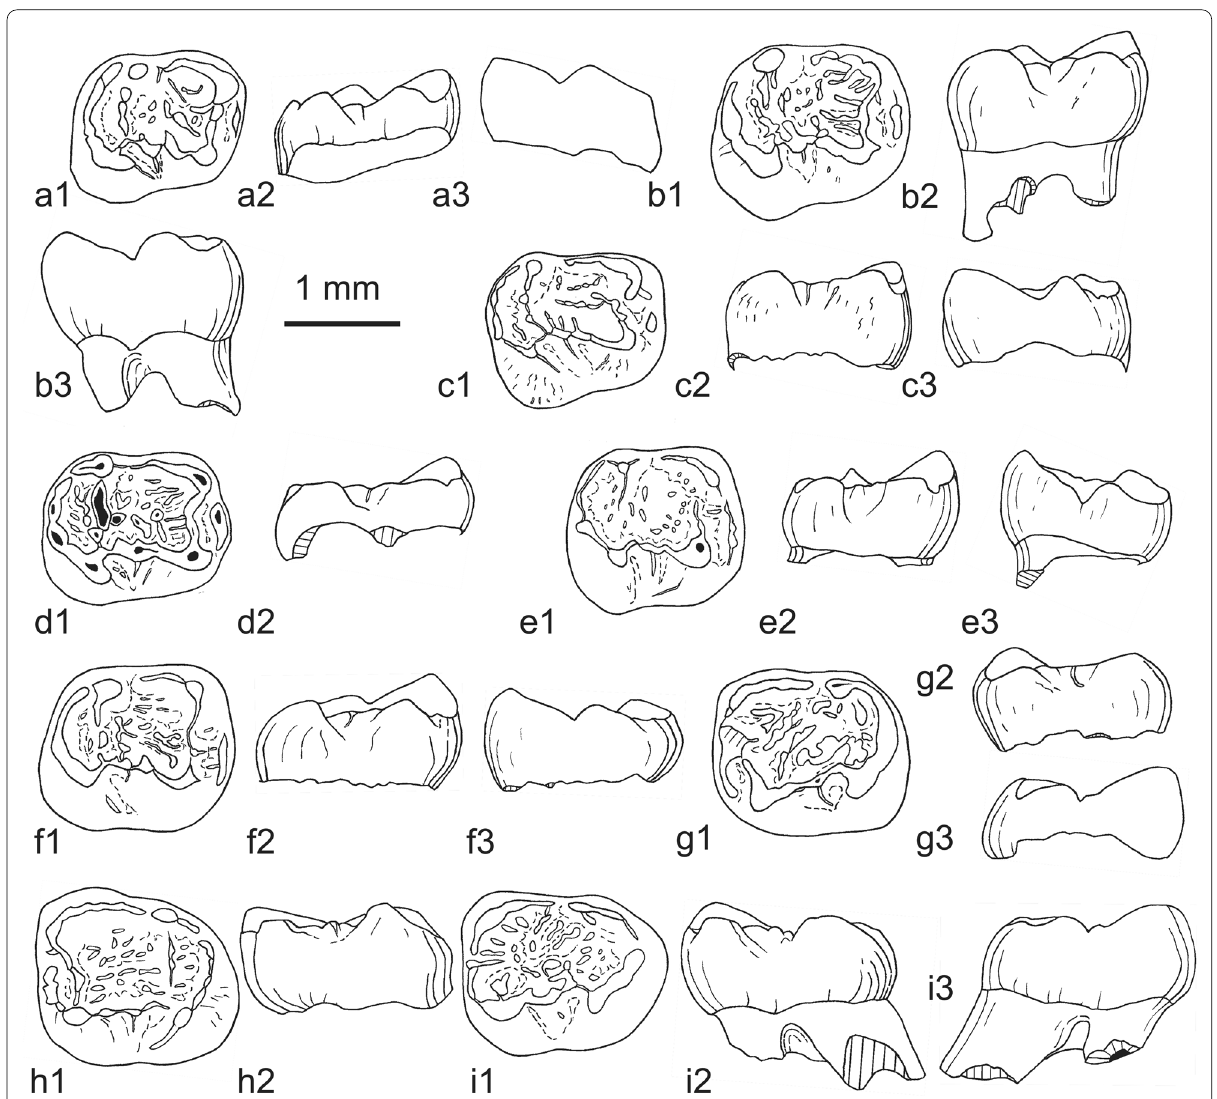
Fig. 48 Lower molars of ? Protadelomys maximini Escarguel, 1998 from Saint‑Maximin (Gard). a SMX1‑213, right m1; a1, occlusal view; a2, buccal aspect; a3, lingual aspect. b SMX1‑214, right m1; b1, occlusal view; b2, buccal aspect; b3, lingual aspect. c: SMX1‑215 right m1; c1, occlusal view; c2, buccal aspect; c3, lingual aspect. d SMX1‑227, right m1; d1, occlusal view; d2, buccal aspect. e SMX1‑231, right m2; e1, occlusal view; e2, buccal aspect; e3, lingual aspect. f SMX1‑250, right m2; f1, buccal aspect; f2, lingual aspect; f3, occlusal view. g SMX1‑248, left m2; g1, occlusal view; g2, buccal aspect; g3, lingual aspect. h SMX1‑242, left m3; h1, occlusal view; h2, buccal aspect. i SMX2‑214, left m3; i1, occlusal view; i2, buccal aspect; i3, lingual aspect. Scale bar 1 =